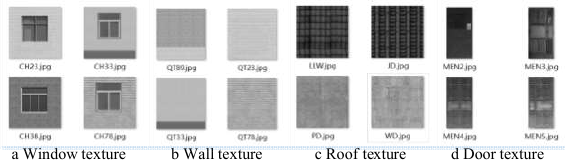
Figure 2. Part of textures in the texture